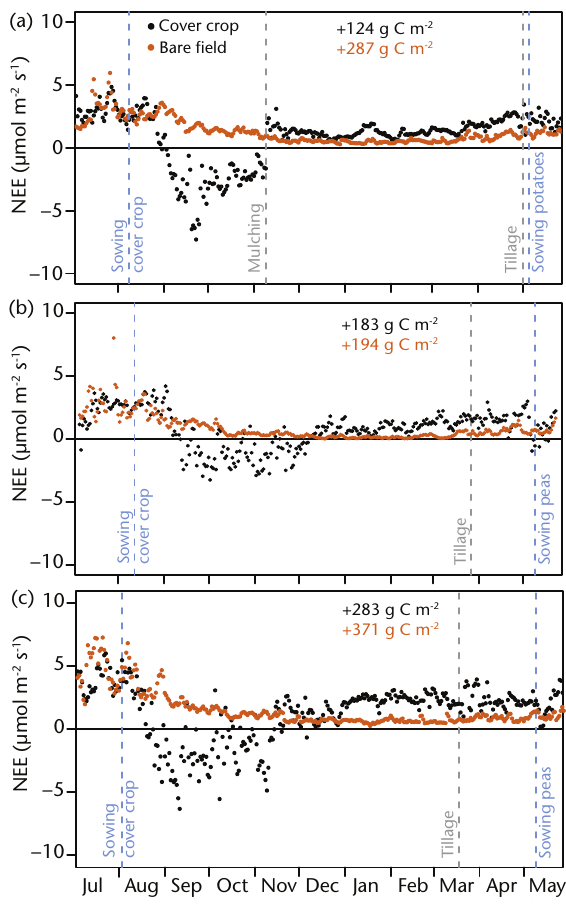
Figure 5. Daily average NEE of the three cover crop seasons (a) 2005–2006, (b) 2009–2010 and (c) 2015–2016, displaying mea- sured data with cover crop and modelled data with a bare field. NEE was measured with an EC system, while modelled NEE was simulated with the model SPA-Crop. Vertical lines indicate sowing, tillage and mulching dates. Numbers in the top right corner of each subfigure are the cumulative NEEs of the field with cover crop in black and bare field in brown.